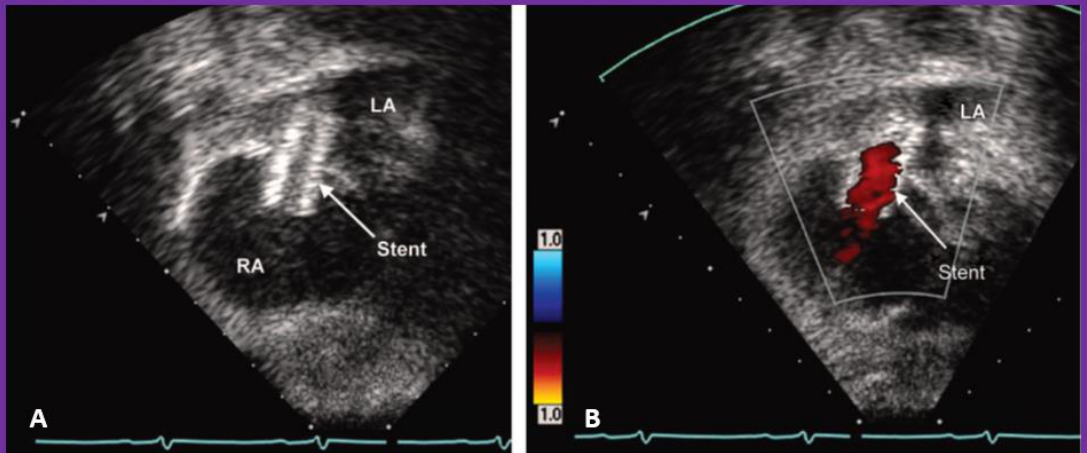
Figure 8. ( A ) . Selected 2D video image from subcostal view of an echo-Doppler study of an infant with mitral atresia who had a stent implanted 1 day prior to the study (Figure 7), illustrating the position of the stent (arrow) across the atrial septum. ( B ) . Same as ( A ) but with color flow mapping. Note laminar flow (arrow) within the stent suggesting non-obstructed flow across the atrial septum. LA, left atrium; RA, right atrium. Reproduced from [4].